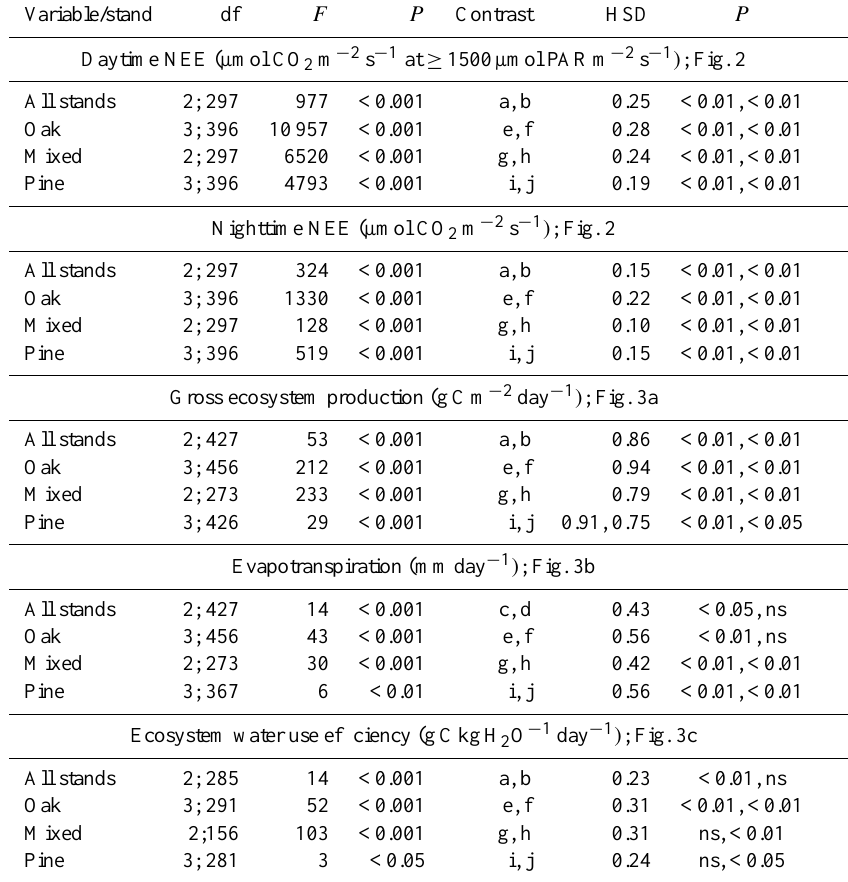
Table 3. Statistics for ANOVA and contrasts for half-hourly daytime and nighttime net CO 2 exchange during the summer (1 June–31 August; Fig. 2), and daily evapotranspiration, gross ecosystem production, and ecosystem water use efficiency during the summer among stands before disturbance, and within stands among years (Fig. 3). df = degrees of freedom, F = the value of the F statistic, and P is the significance level for ANOVA analyses. Contrasts for all stands before disturbance are; a: oak vs. mixed and pine, b: mixed vs. pine, c: oak and pine vs. mixed, d: oak vs. pine. Oak stand contrasts are; e: complete defoliation vs. pre- and post-defoliation, f: pre-defoliation vs. post- defoliation. Mixed stand contrasts are; g: pre-disturbance vs. disturbance, h: prescribed burn vs. defoliation. Pine stand contrasts are; i: pre- and post-disturbance vs. disturbance, j: defoliation vs. prescribed burn. Tukey’s Honestly Significant Difference (HSD) tests were used to determine significance levels of each contrast, and P is the significance level for each